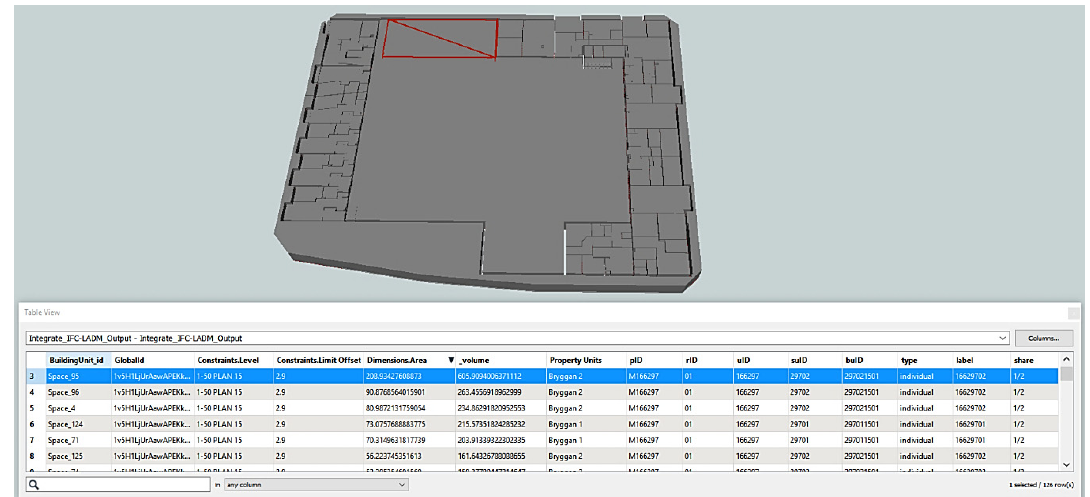
Figure 14. The integrated IFC-LADM model with the table of attributes.